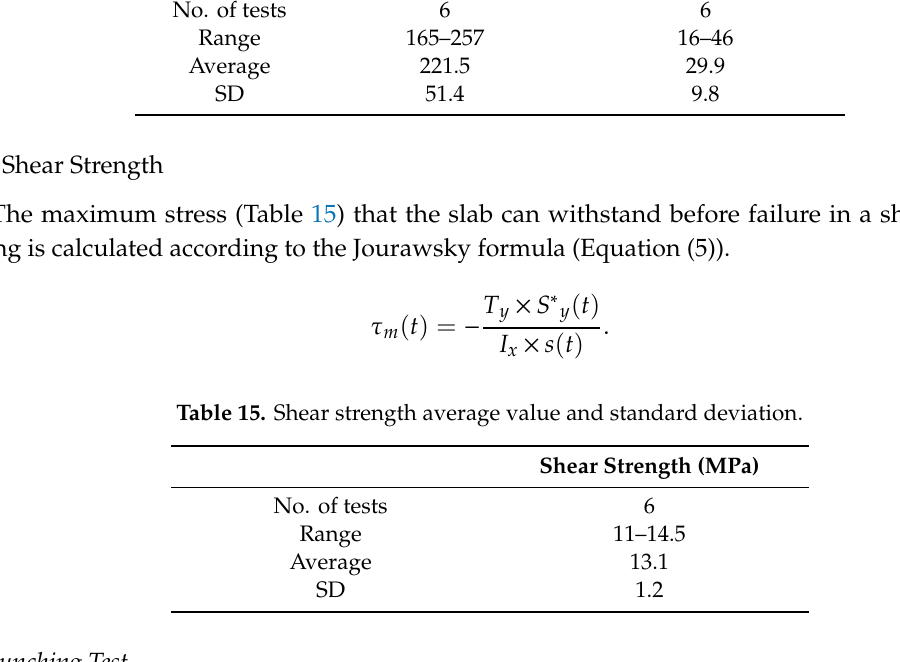
Table 16. Max-load and corresponding deflection average value and standard deviation.